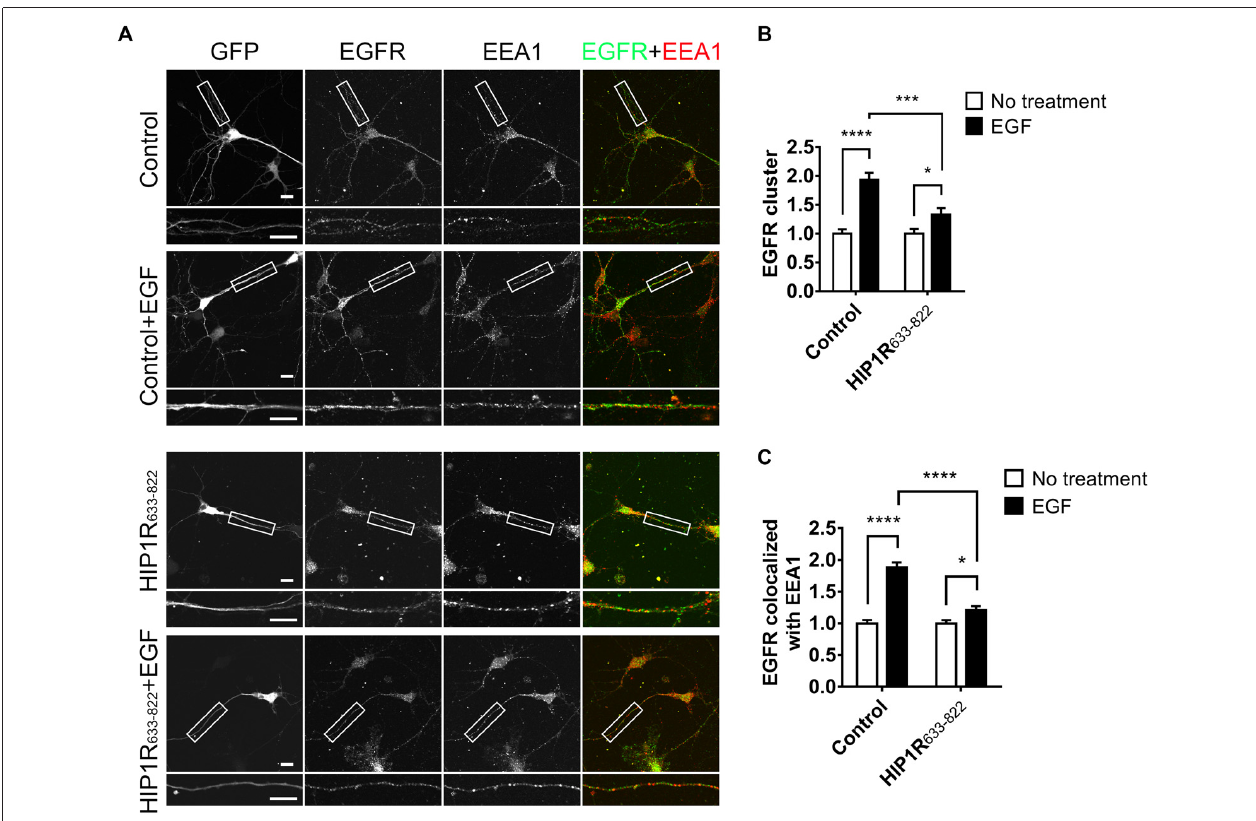
FIGURE 9 | HIP1R 633–822 overexpression influences the internalization of EGFR. (A) Representative images of neurons electroporated with GFP or GFP-HIP1R 633–822 constructs and treated with EGF for 15 min, labeled for GFP, EGFR and EEA1. Scale bar, 20 µ m. (B,C) Quantification of EGFR clusters (B) and the colocalization of EGFR and EEA1 clusters (C) in control and HIP1R 633–822 groups ( n = 34 and 59 neurons for control groups, and 42 and 41 neurons for HIP1R 633–822 groups). Mean ± SEM, ∗ p < 0.05; ∗∗∗ p < 0.001; ∗∗∗∗ p < 0.0001; n = 3 independent cultures; unpaired two-tailed t